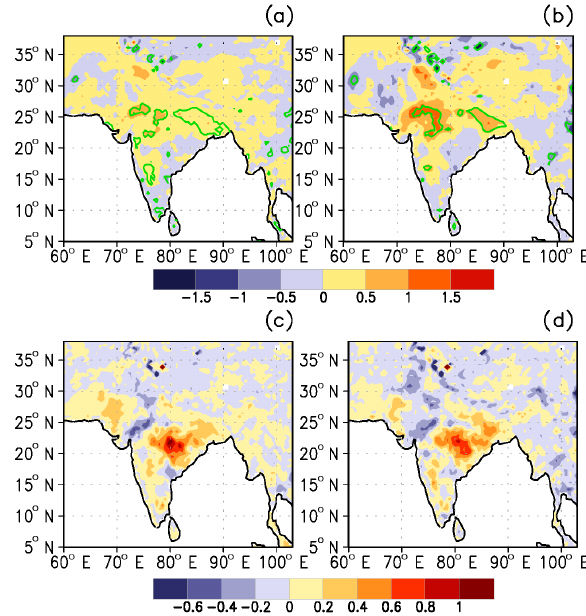
Figure 9. Difference (PLC–HLC) in daily variance of 2m air tem- perature in JJAS (in ◦ C 2 ; 1982–2008) for (a) daily mean, and (b) daily maximum temperature. Green contour shows significance at the 90% confidence level. Difference (PLC–HLC) in the 90th percentile of daily 2m air temperature in JJAS (in ◦ C; 1982–2008), for (c) daily mean, and (d) daily maximum